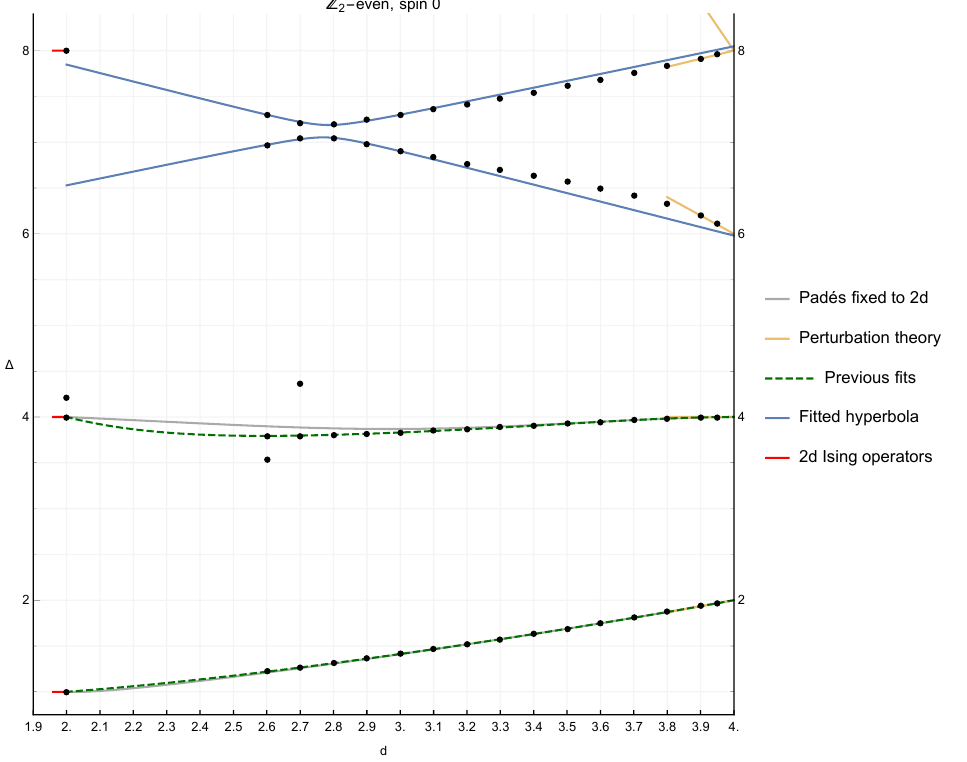
Figure 20 . Plot showing the collected state-of-the-art picture for the first four Z 2 -even scalars, including our preliminary results in d = 2 . 001 . The dots refer to results from the numerical bootstrap study, the gray lines are Padé approximants computed from the ε -expansion and values in 2d, the green dashed lines to previous fits from [14], and blue lines to the hyperbola fit from the mixing region, (4.9). Red markers denote the position of quasiprimaries in d = 2 . Note that [14] has values for the first two operators for a more dense sampling of values of d near d = 2